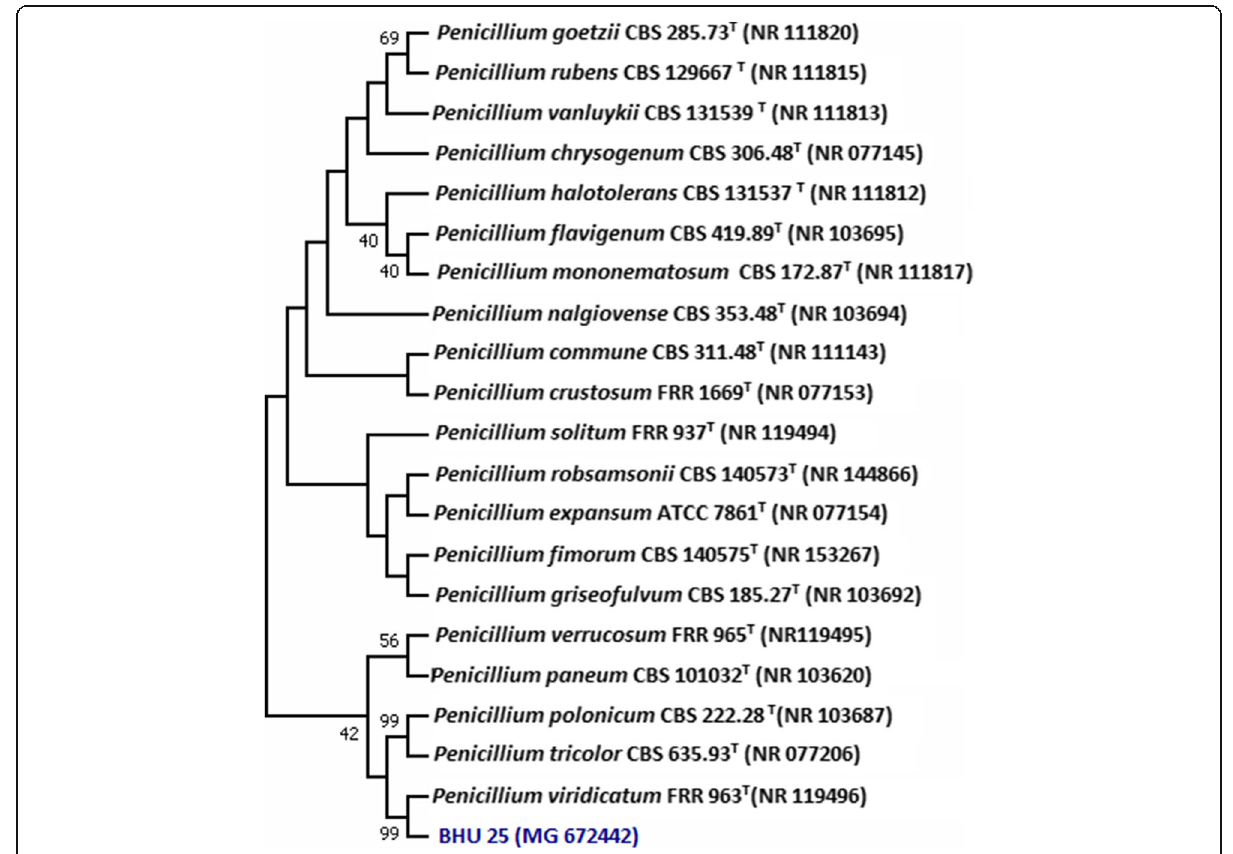
Fig. 7 Phylogenetic tree of Isolate BHU-25 obtained by maximum likelihood method based on the Kimura 2-parameter model. The percentage of replicate trees in which the associated taxa clustered together in the bootstrap test (1000 replicates) are shown next to the branches. The position of Isolate BHU 46 is shown with blue color. It is most closely related with Penicillium viridicatum and supported by boot strap value of